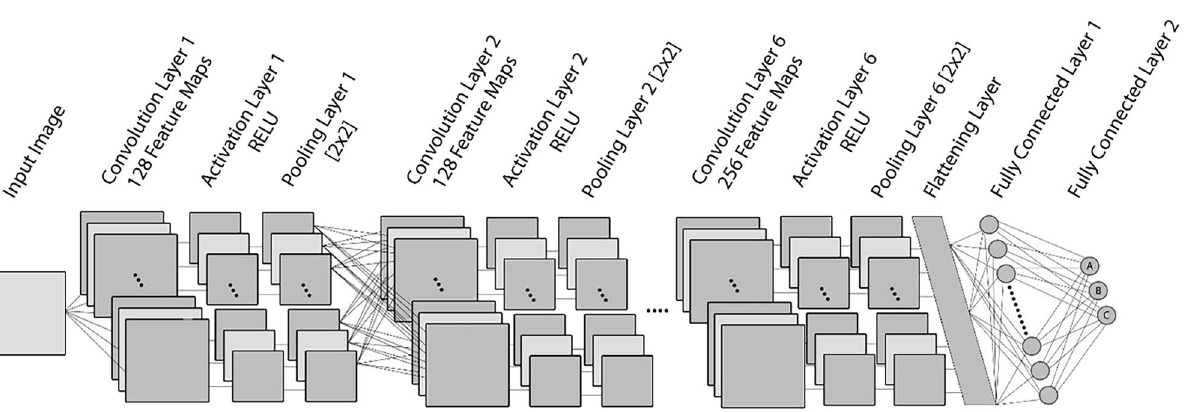
Figure 4. Proposed CNN Architecture for LPC of